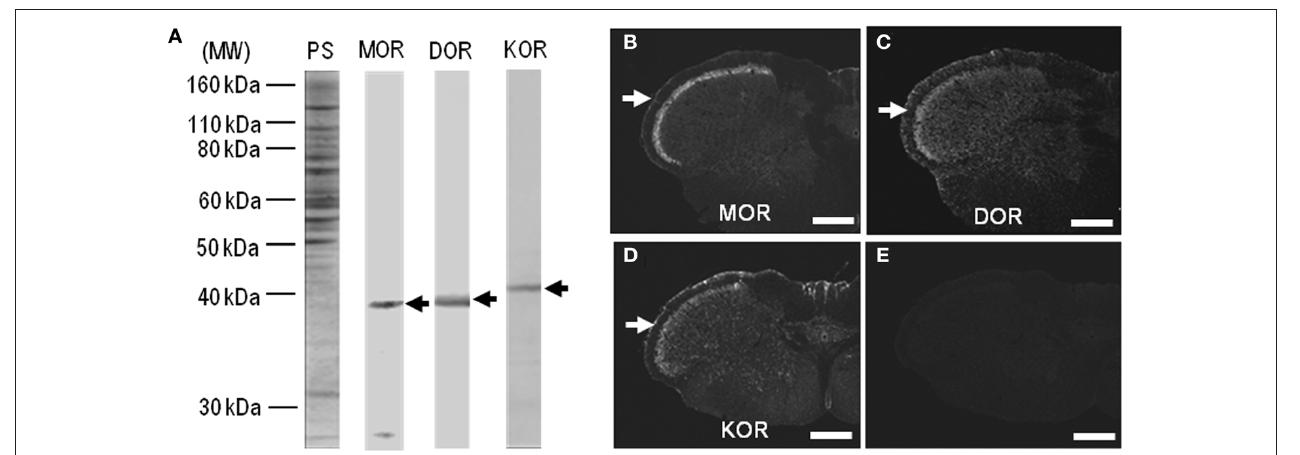
staining. (B–D) Single-label TSA immunostaining of the upper cervical spinal cord by using the antibodies against MOR (B) , DOR (C) , or KOR (D) . Arrows indicate the superficial layers of the dorsal horn of the spinal cord. (E) No specific immunoreactivity was found in the spinal cord processed for the TSA protocols in the absence of the primary antibodies. Scale bar = 500 μ